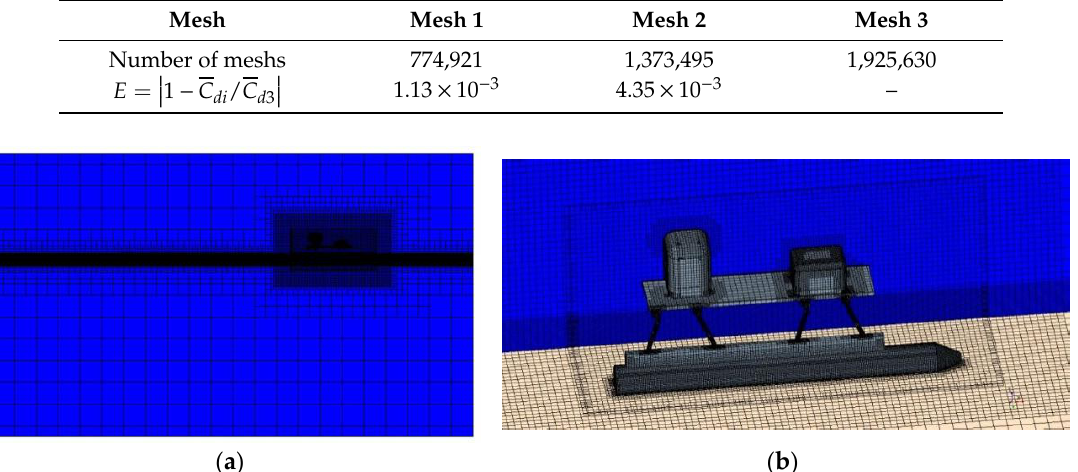
Figure 3. Mesh Generation and Distribution. ( a ) Three-dimensional Mesh Generation; ( b ) Grid Distribution Around the Wall.